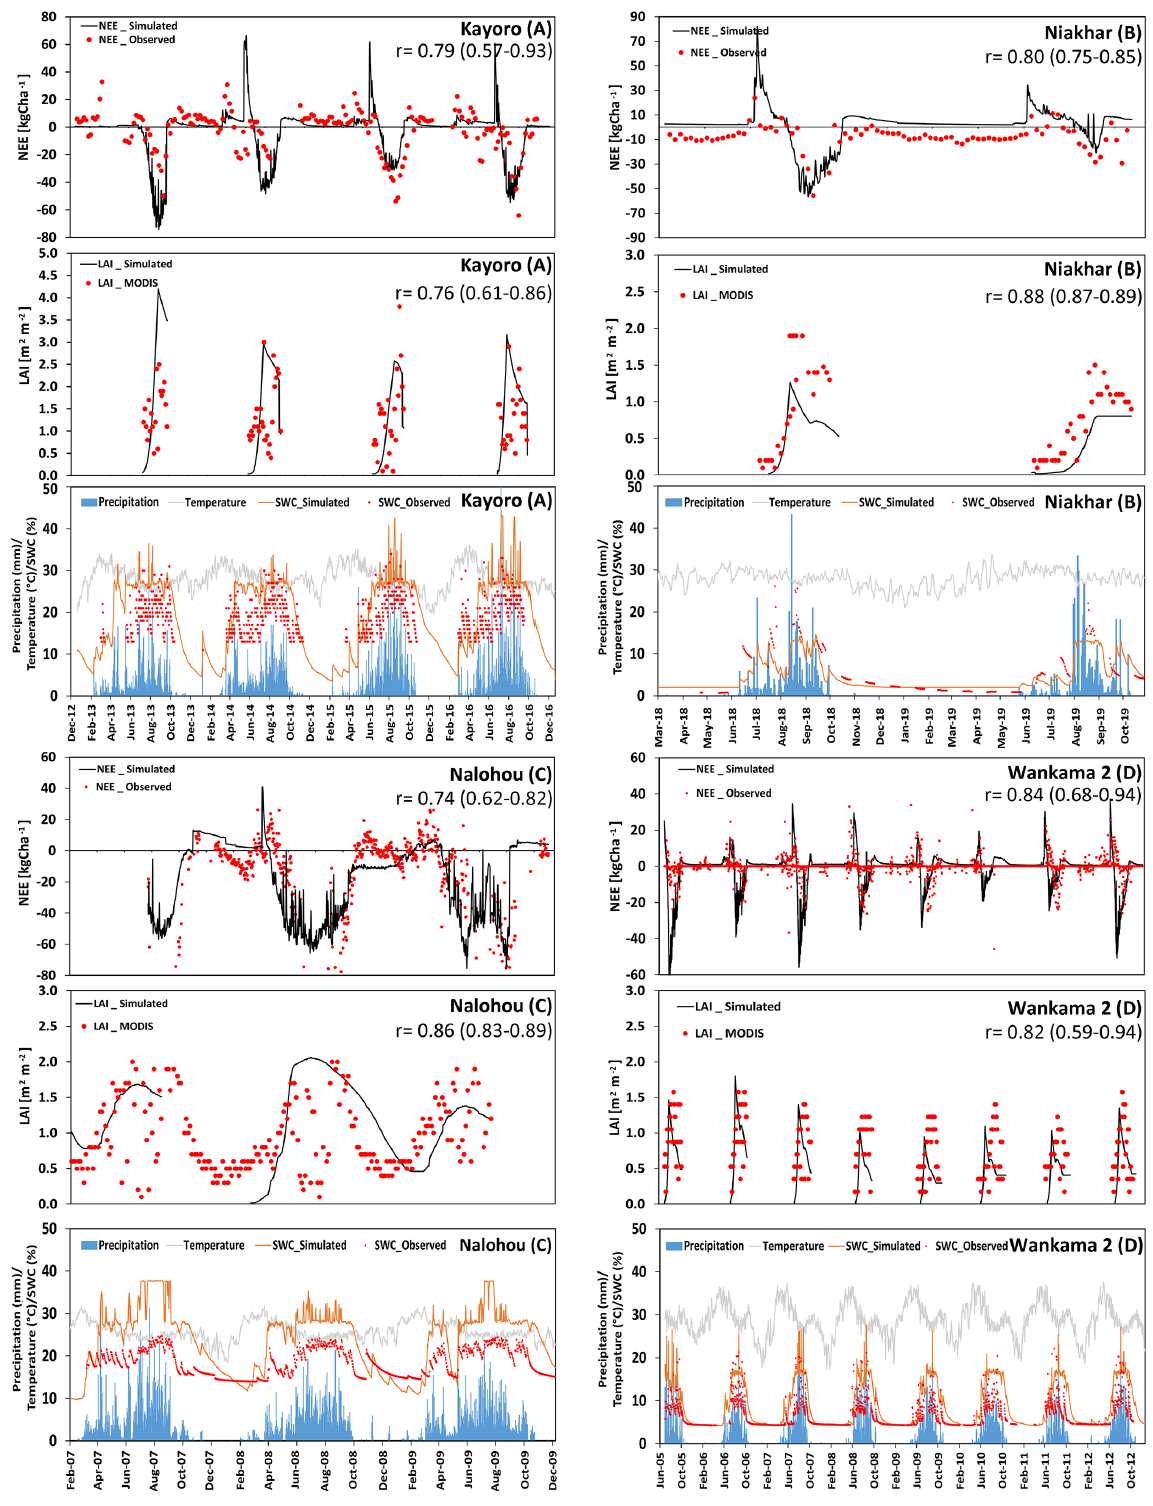
Figure 3. (a–d) Time series of the observed and modeled NEE (kgha − 1 ; negative values represent a flux into the biosphere, and positive values represent a flux towards the atmosphere), LAI (m 2 m − 2 ), and soil-water content (at 10cm depth). In addition, precipitation and temperature at four different crop-dominated sites in the Sahelian (d) and Sudanian (a–c) ecological zones are presented.